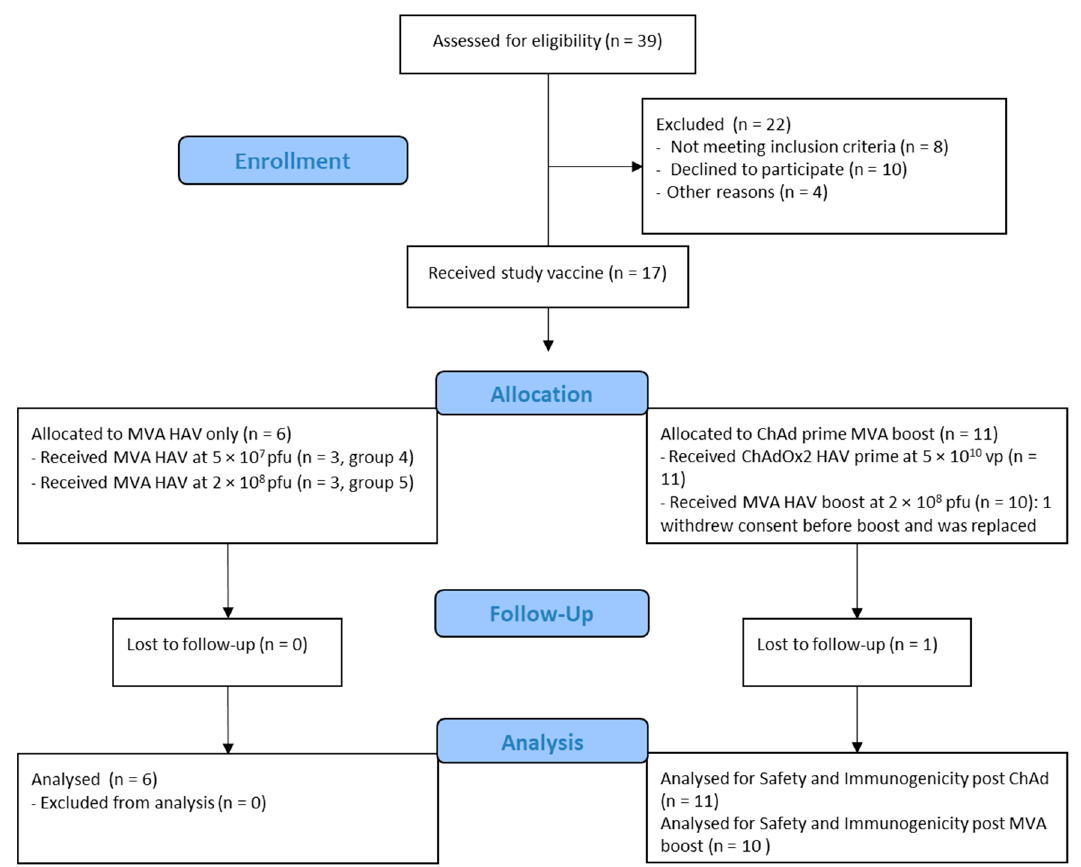
Figure 1. Consolidated Standards of Reporting Trials (CONSORT) diagram.